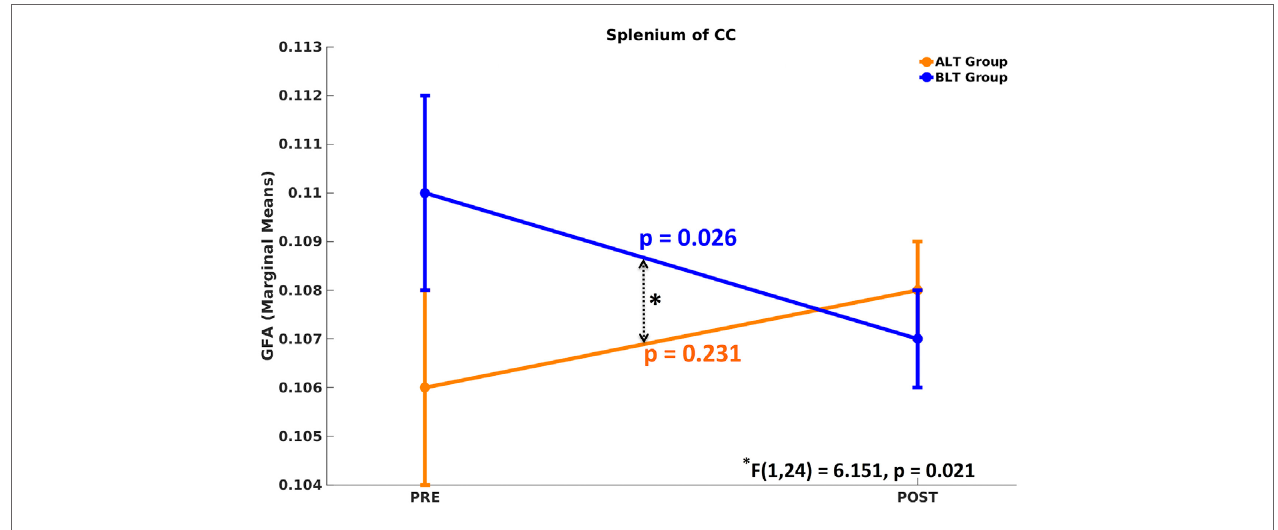
FigUre 2 | Mixed analysis of covariance of generalized fractional anisotropy (GFA). Compared to baseline, only the fibers crossing the splenium of corpus callosum (CC) showed significant differences in GFA following blue-light therapy (BLT). No significant difference in GFA was found for fibers crossing any brain area, including the splenium of CC, following amber-light therapy